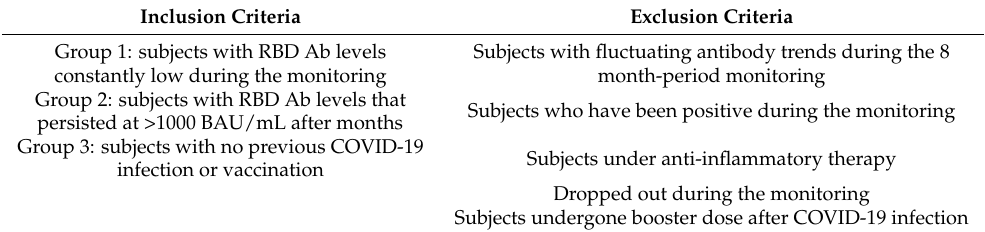
Table 1. Inclusion and exclusion criteria of the subjects that were enrolled for the IGRA test (No. 23 out of